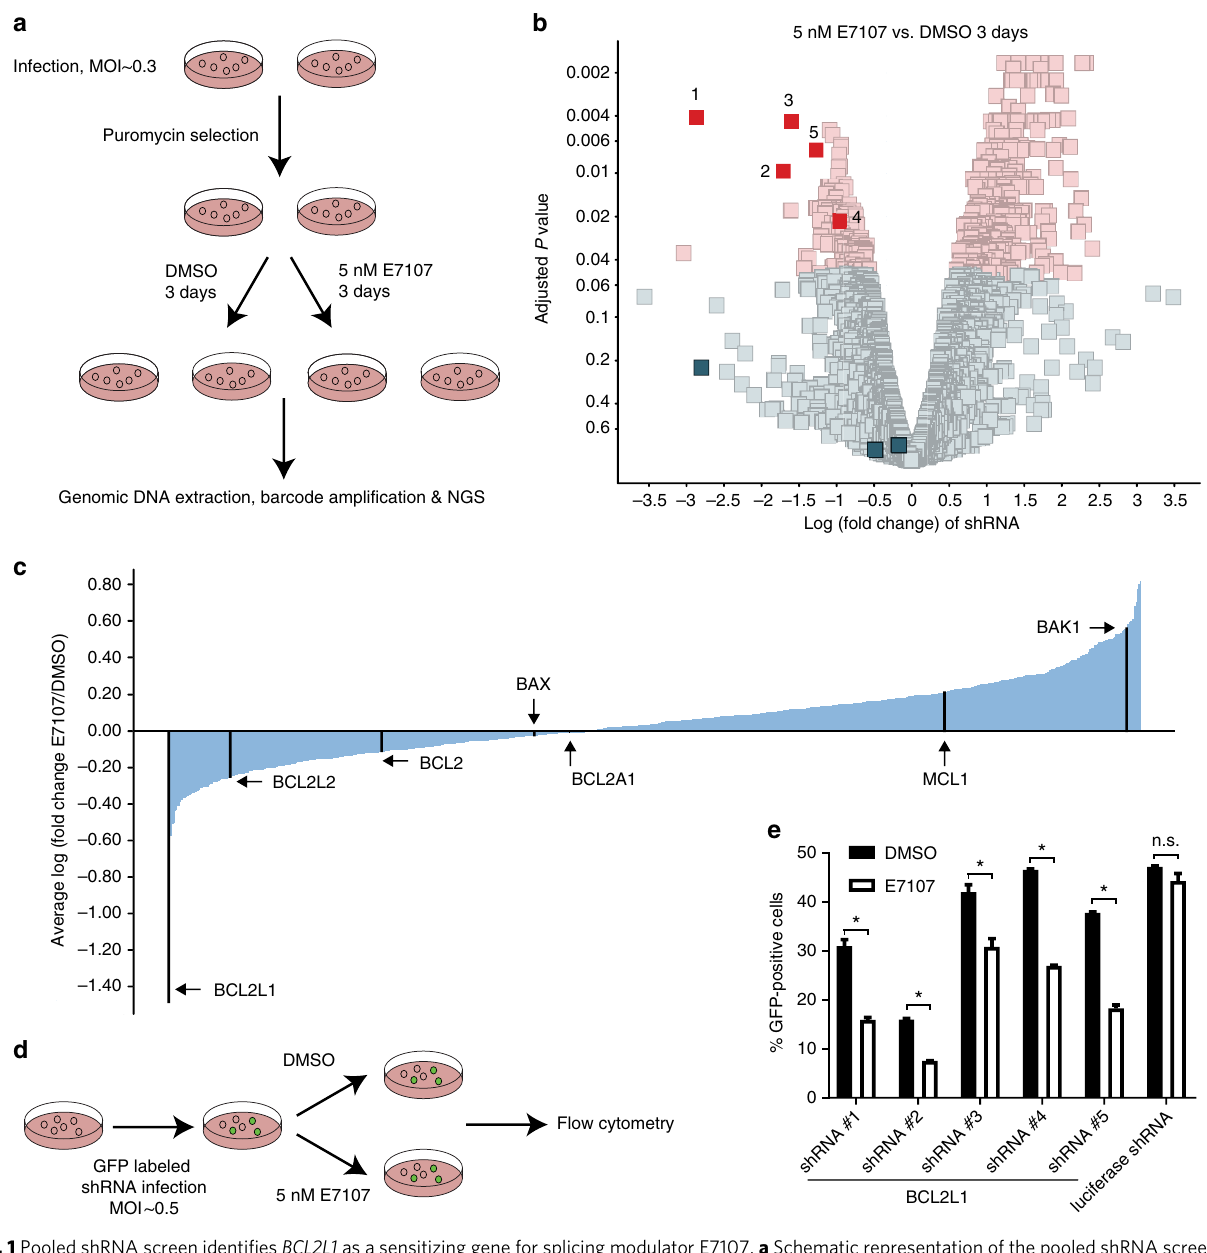
Fig. 1 Pooled shRNA screen identi fi es BCL2L1 as a sensitizing gene for splicing modulator E7107. a Schematic representation of the pooled shRNA screening in NALM6 cells treated with solvent DMSO or E7107. b Volcano plot demonstrating the log 2 (fold change) and adjusted p value (moderated t test by limma) of each shRNA in the pool screen (E7107 vs. DMSO, biological duplicates). For log 2 (fold change), negative and positive numbers represent drop- out (sensitization) and enrichment (resistance) phenotype, respectively, in combination with E7107 treatment. Red dots show shRNAs that are signi fi cantly (adjusted p < 0.05) altered in the screen. c Waterfall plot showing the average log 2 (fold change) (E7107 vs. DMSO) of shRNAs targeting the same gene included in the shRNA pool. Five antiapoptotic and two proapoptotic BCL2 family genes were marked in black. d Schematic representation of a GFP-tracking phenotypic validation using single shRNAs against BCL2L1 in NALM6 cells. e FACS analysis of the percentage of GFP-positive NALM6 cells infected by individual shRNAs after 72 h treatment with DMSO or E7107. Data represent means ± SD of biological duplicates. * p < 0.05, n.s. not signi fi cant, p > 0.05 by Student ’ s t